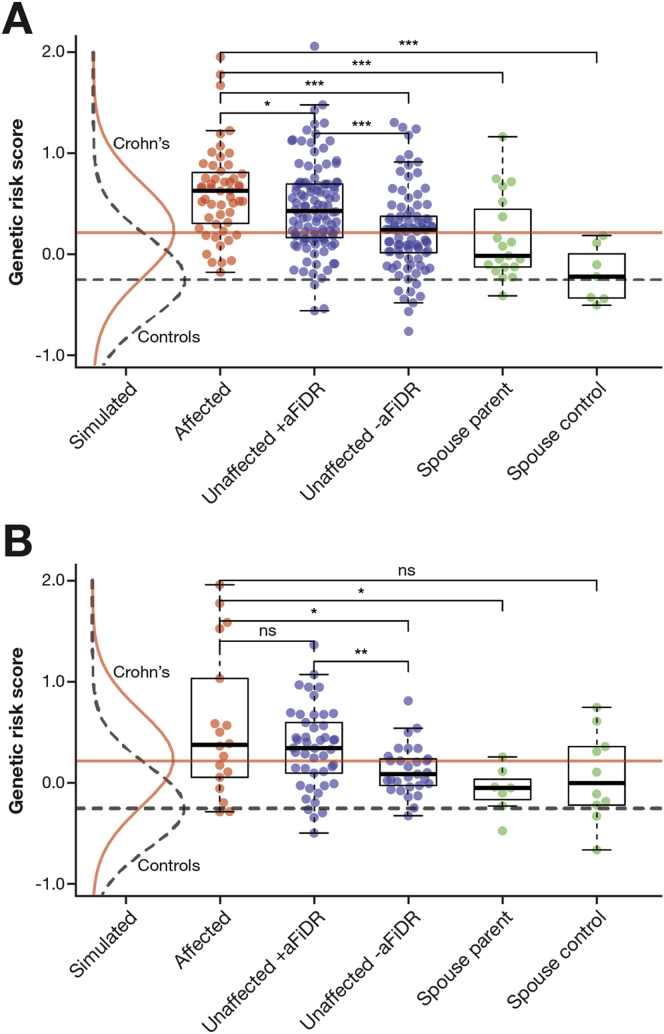
GRS in affected and unaffected individuals in (A) Family A and (B) Family B. Unaffected individuals have been divided into those with (+aFiDR) and without (-aFiDR) at least 1 affected first-degree relative. Spouse controls; founders with no affected descendants; spouse parents; founders with 1 or more affected offspring. (A and B) The distribution of GRS in a simulated theoretical control and Crohn’s disease population (along with the corresponding medians) is indicated. *P <.05, **P <.01, and ***P <.001 (Mann–Whitney–Wilcoxon test).